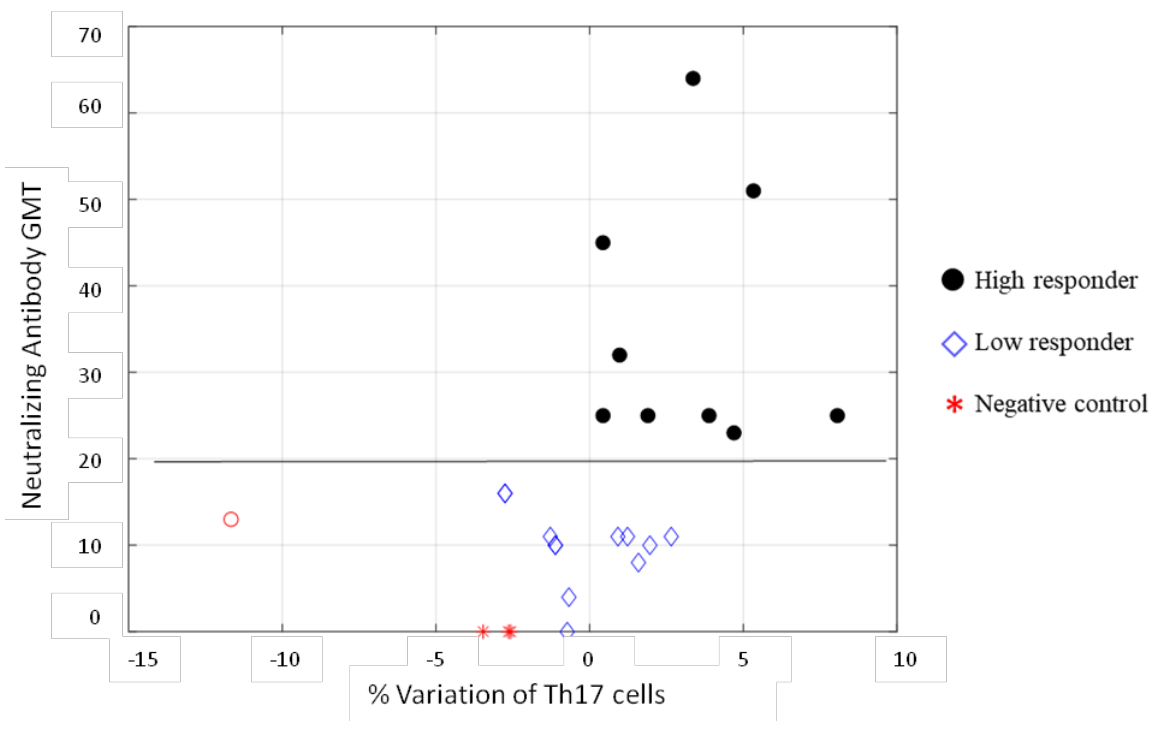
Figure 5. Representation of the % variation after stimulation of the CD4 + Th17 population, normalized with respect to total CD4 + counted cells, with respect to NT antibody GMT. It is possible to notice that a cut-off can be set with an NT value of 19.5 (calculated average). The red circle was considered an outlier.